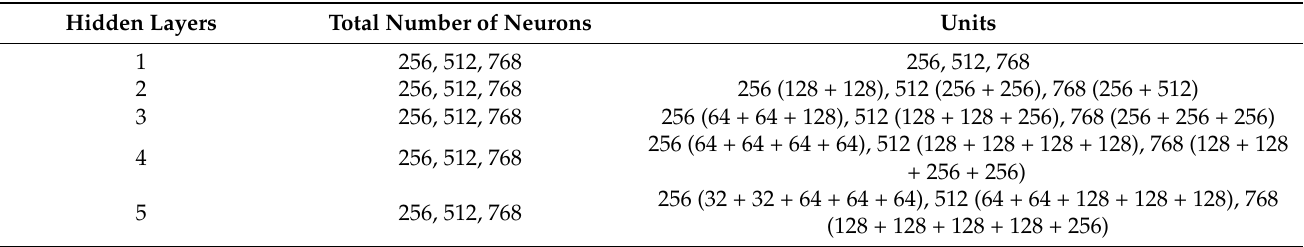
Table 6. Benchmarks of neural network architectures.